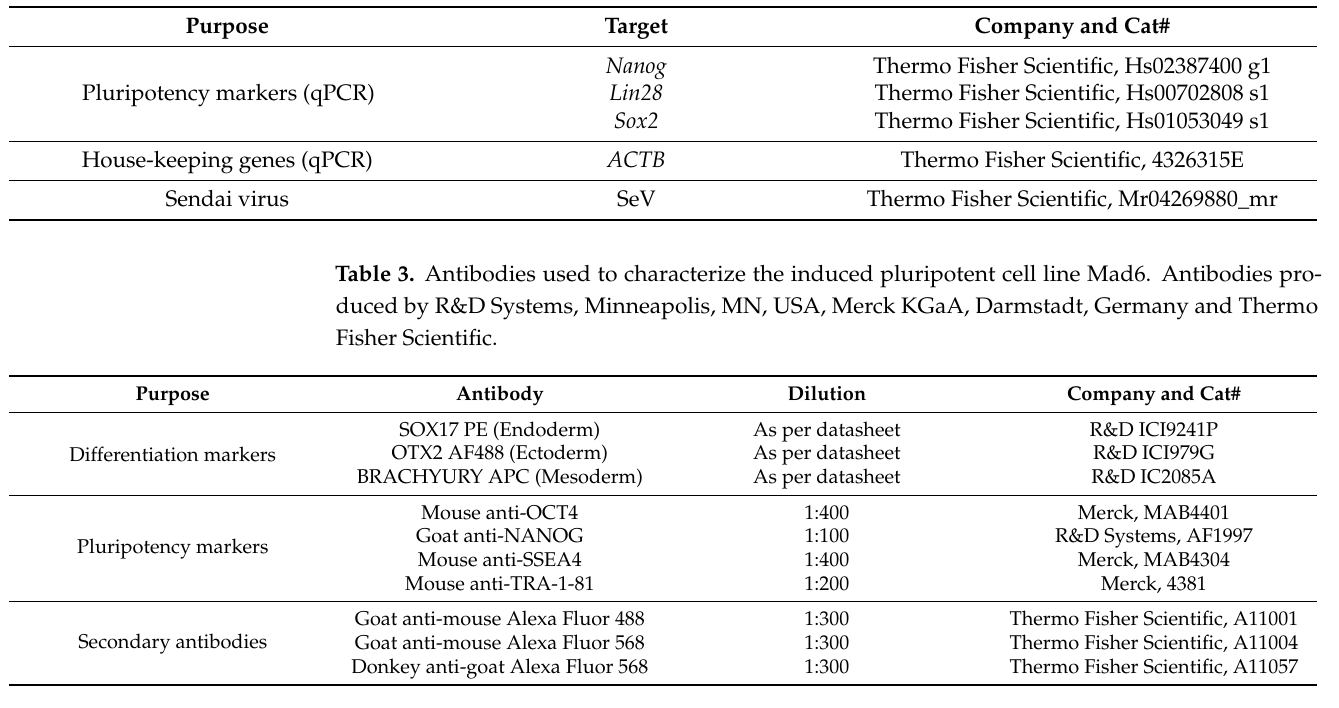
Table 2. qPCR probes used to characterize the induced pluripotent cell line Mad6.